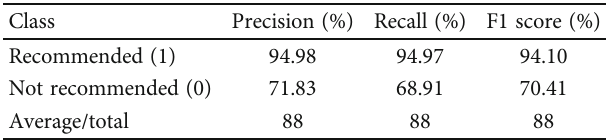
Table 12: Recommended classi fi cation and result metric usage on